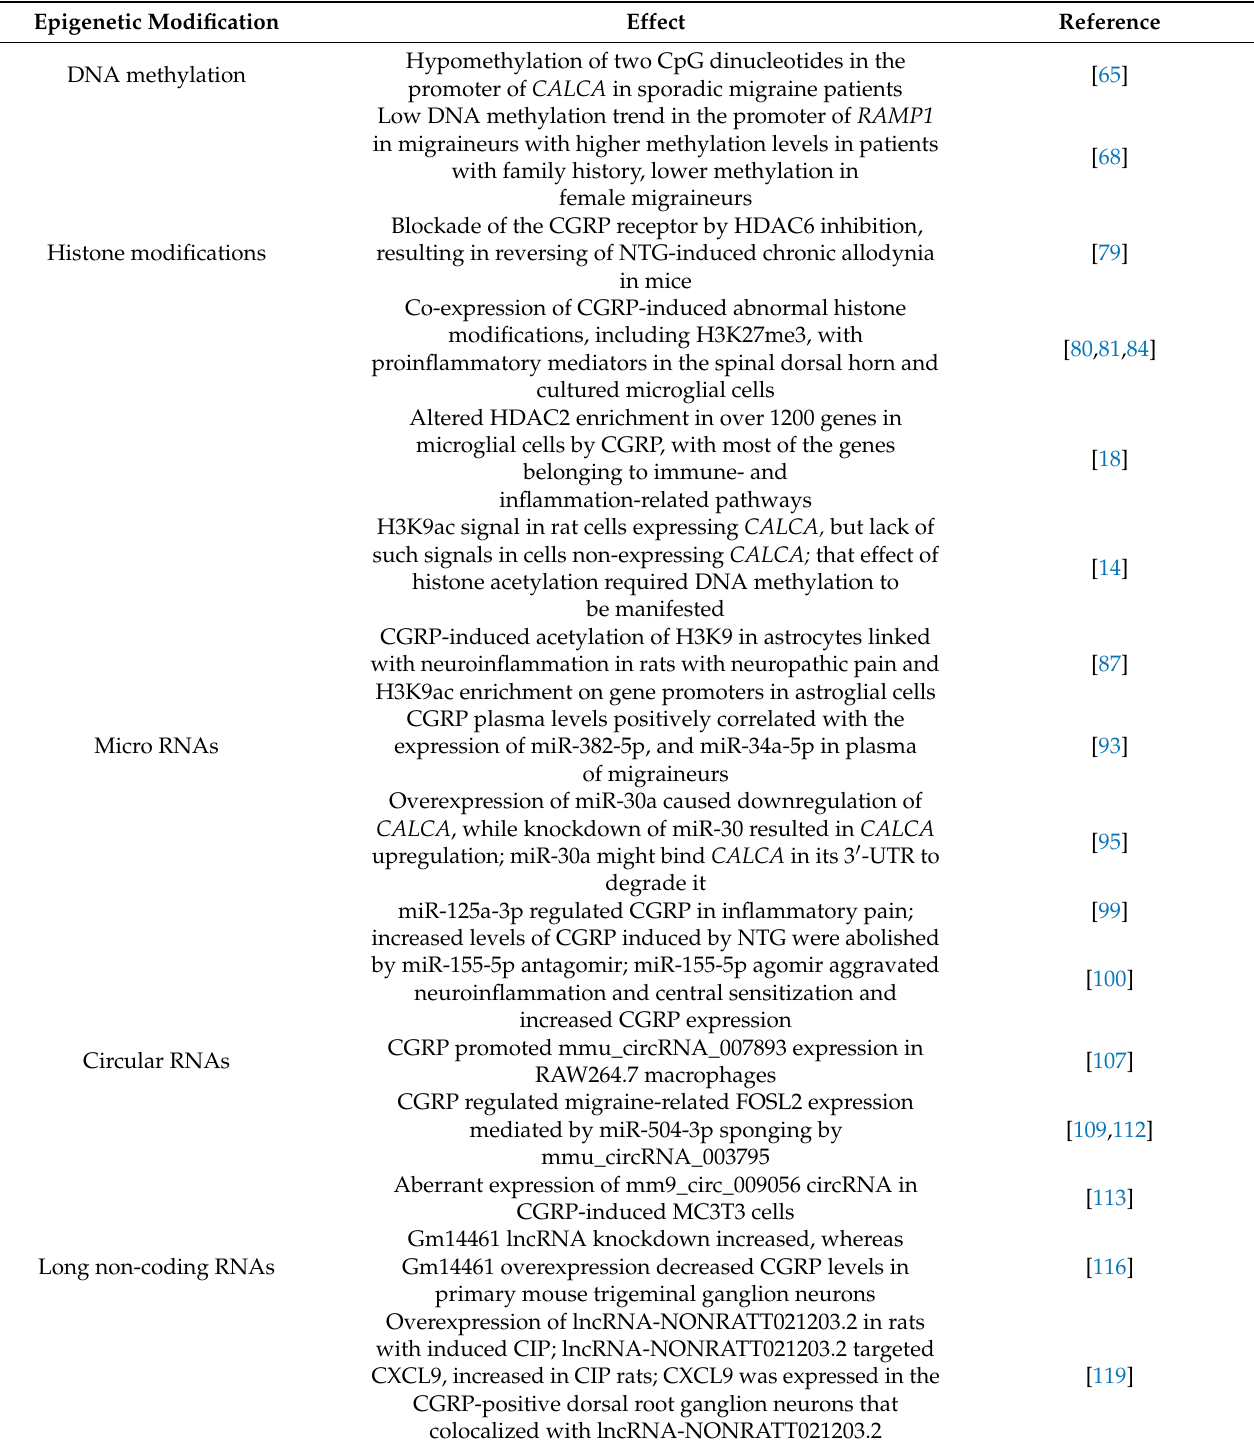
Table 1. Epigenetic effects related to CGRP 1 in migraine and migraine-associated